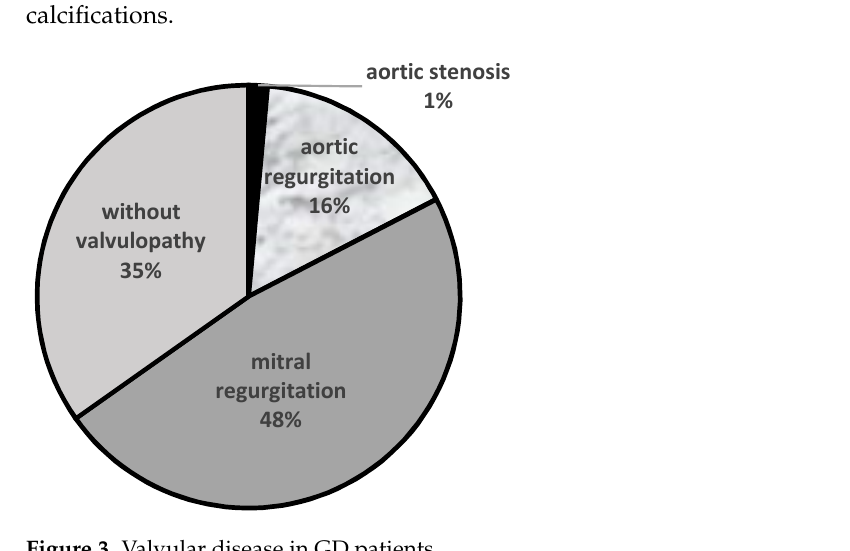
Figure 3. Valvular disease in GD patients. Genotypes of the patients with valvular involvement are presented in Table 6. We found no correlation between the most common mutations and the presence of valvular involvement or its severity. Table 6. Genotype of patients with